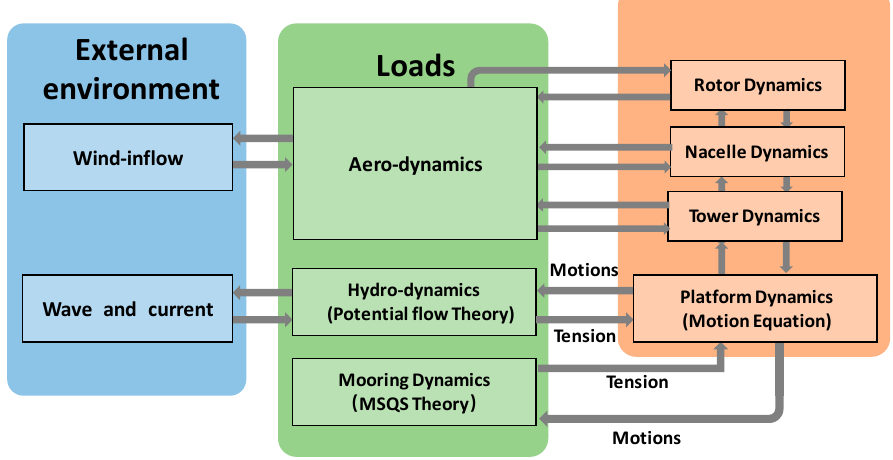
Figure 1. Modules in the in-house codes.